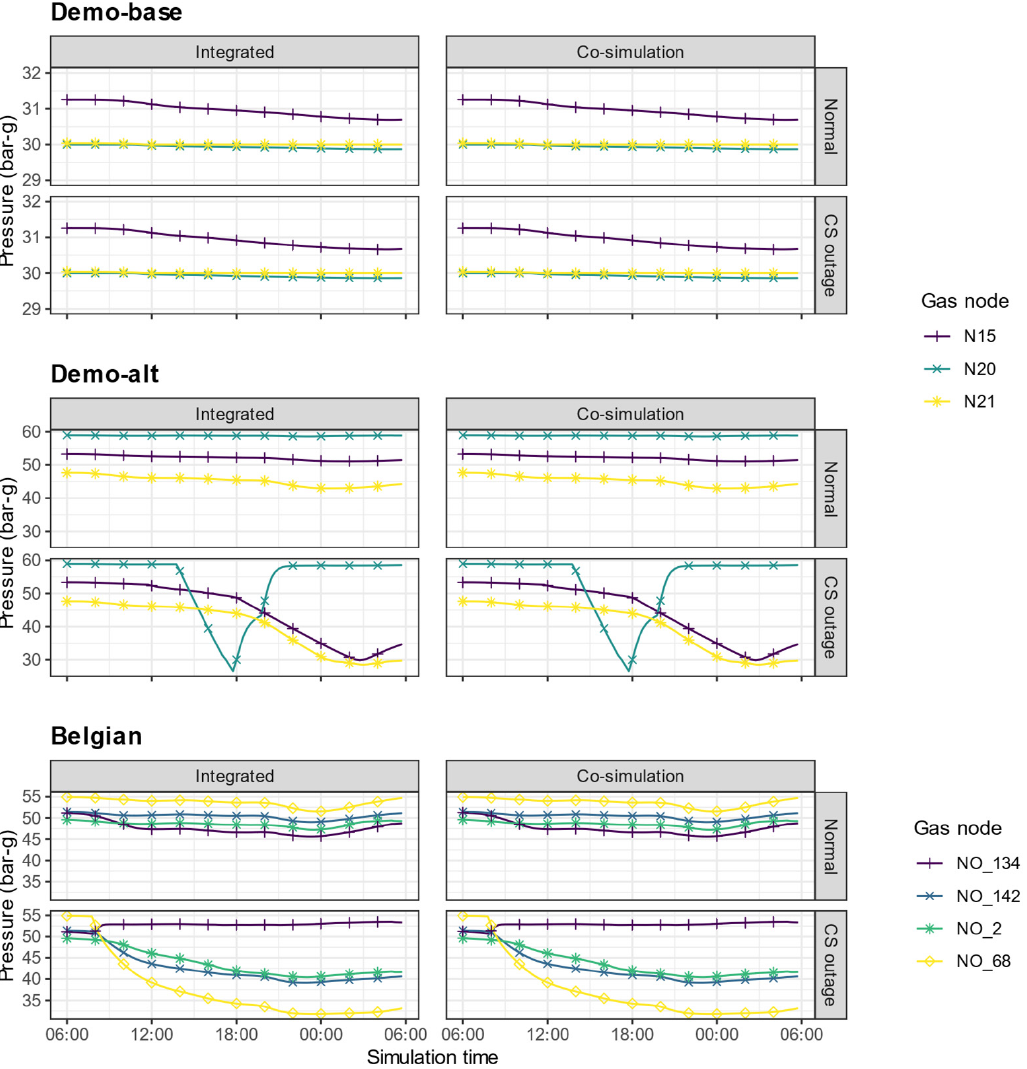
Figure 5. Pressure (bar-g) at gas delivery nodes that are coupled to the power system for each network and disruption scenario. The maximum MAPE across all scenarios is 0.012%.